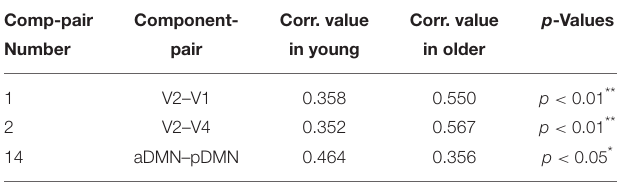
TABLE 4 | Component-Pair Correlations and FDR -adjusted p -values for the three component-pairs exhibiting statistical difference between the two population